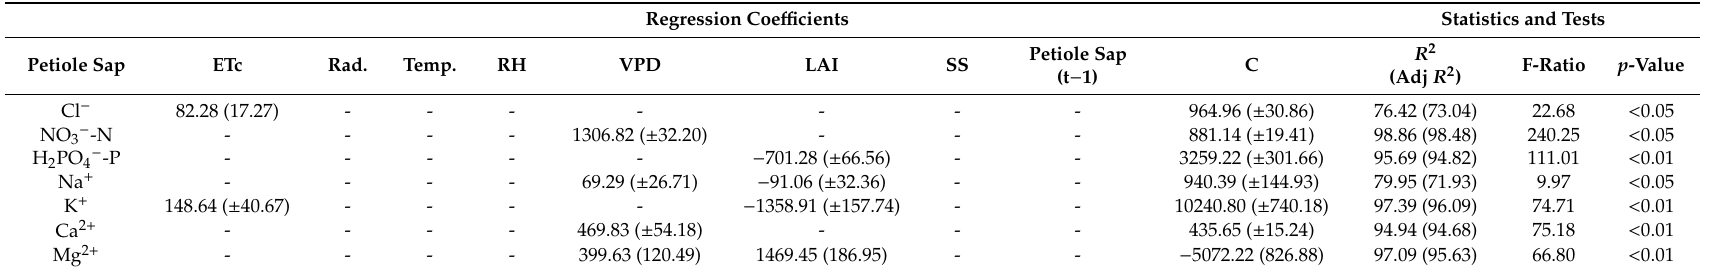
Table 5. Parameters of linear multiple regression between petiole sap (mg L − 1 ), climatic parameter (ETc (mm day − 1 ), global radiation (MJ m − 2 day), temperature ( ◦